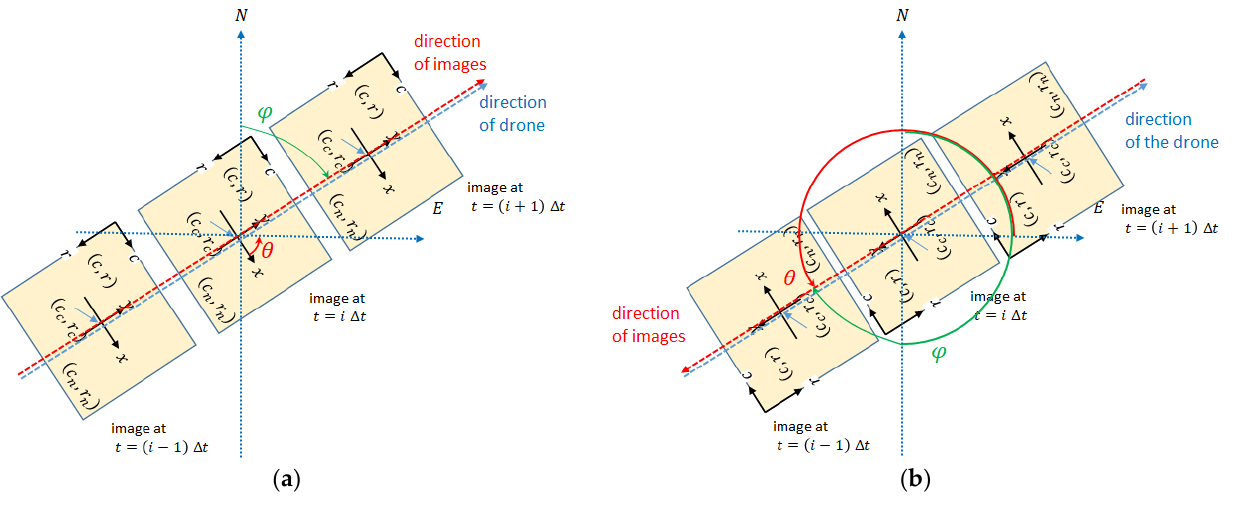
Figure 2. Image direction and the drone’s moving direction: ( a ) drone moving in the same direction; ( b ) drone moving in the opposite direction.